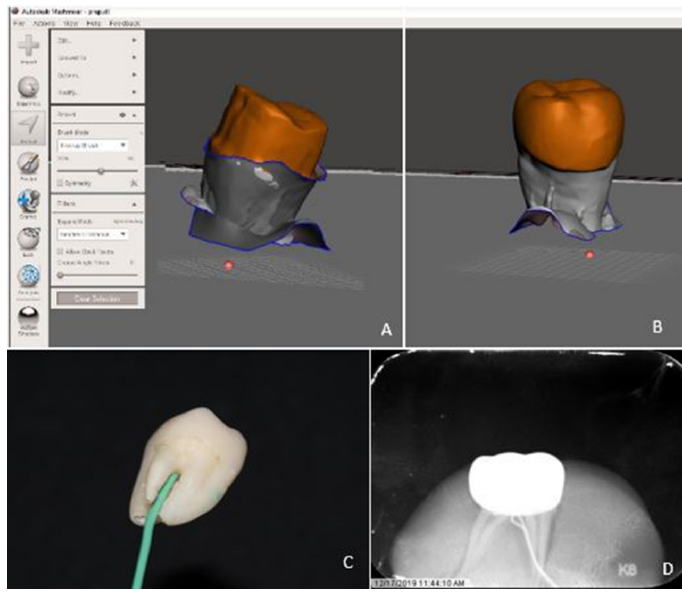
Figure 1. Prepared surfaces of teeth ( A ) and cameo surfaces of the crowns ( B ) were scanned to calculate tooth surface area and the tooth volume. To measure pulpal temperature changes, a 3 mm